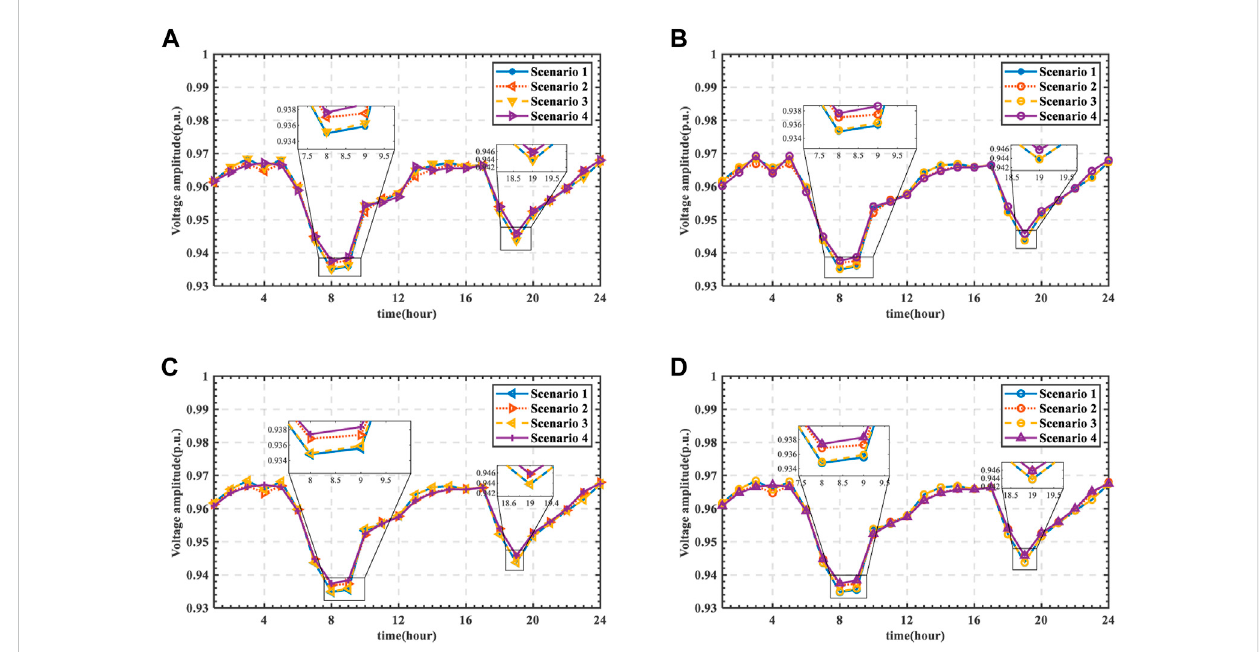
FIGURE 12 Distribution of minimum voltage amplitude for the shortest travel time path.